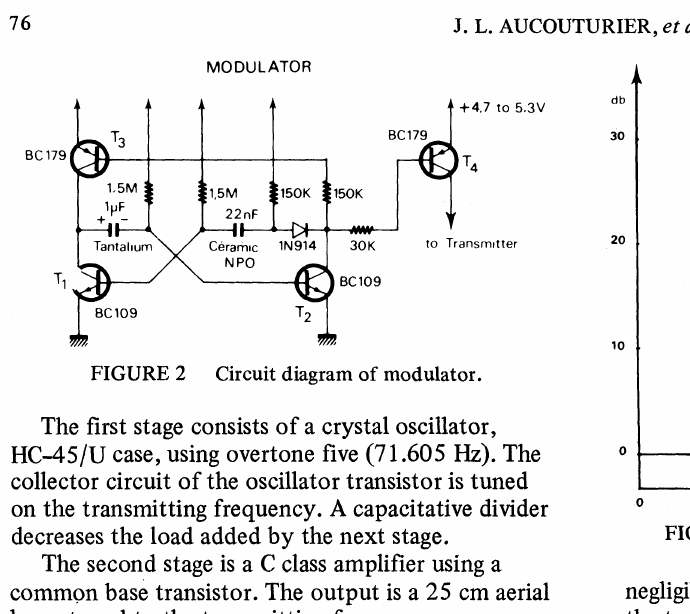
FIGURE 4 Spectral analysis of transmitted